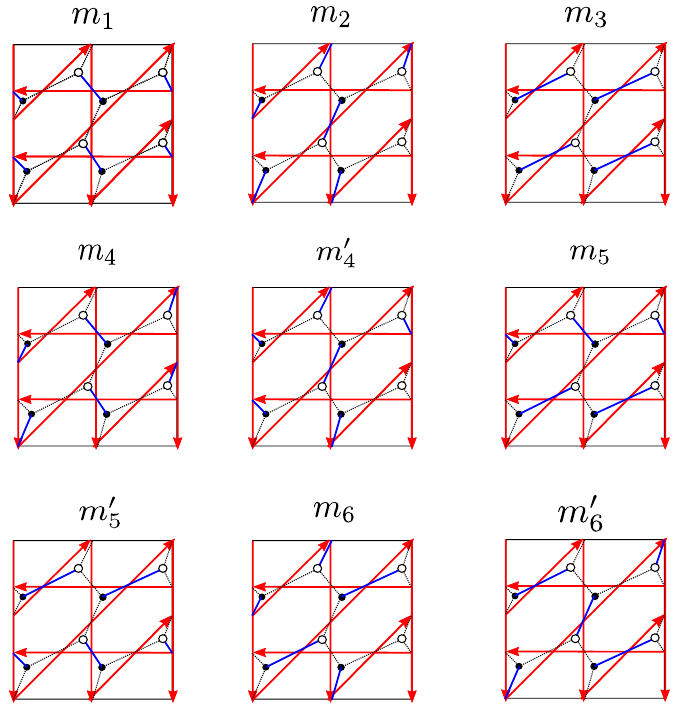
Figure 40. Perfect matchings of C 3 / ( Z 2 × Z 2 ) . Perfect matchings m 1 , m 2 , and m 3 correspond to corner divisors p perfect matchings of p m 2 = { α 1 , β 1 , l 23 , r 23 } , m 3 = { α 2 , β 2 , l 13 , r 13 } , m 4 = { α 1 , α 3 , l 12 , r 23 } , m 0